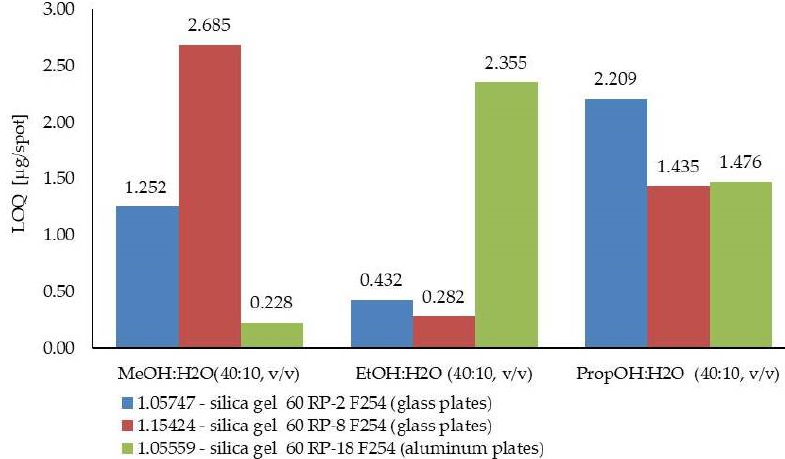
Figure 7. Comparison of average LOQ values of ibuprofen determined by RP-TLC. (MeOH = methanol, EtOH = ethanol, PropOH = propan-1-ol).